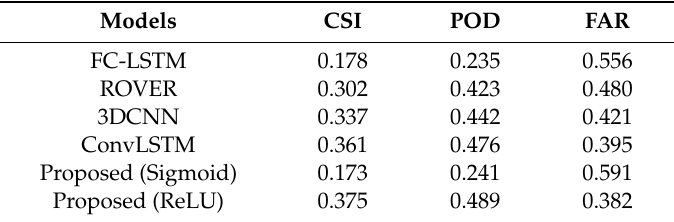
Table 4. Performance comparison of di ff erent models of the 20dBZ